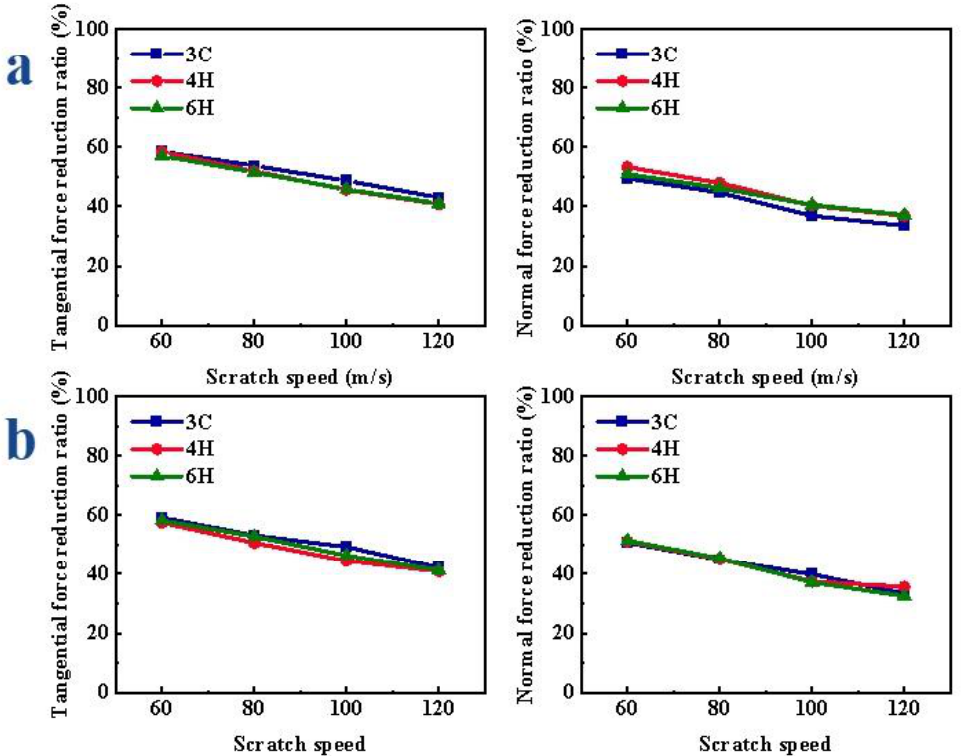
Figure 6. Variation in scratch force reduction ratio of SiC polytypes with different speeds: ( a ) Si-face and ( b ) C-face of SiC.